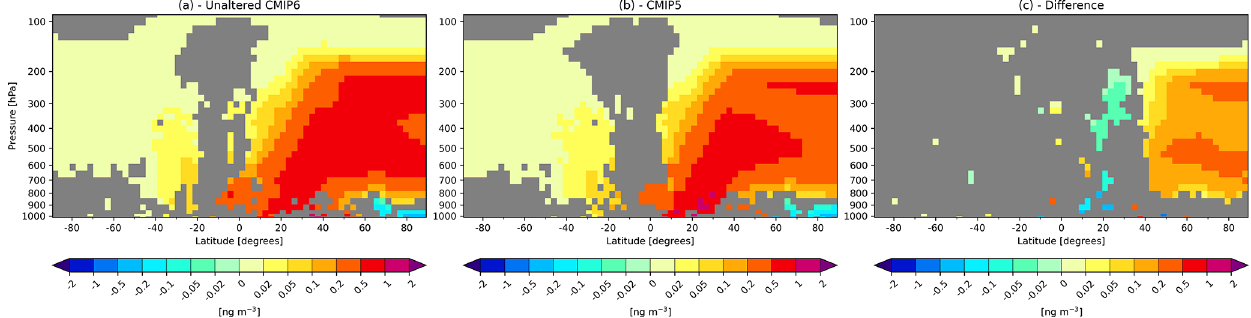
Figure 3. Zonally averaged aviation-induced changes in black carbon concentration simulated by the model using the unaltered CMIP6 (a) and CMIP5 (b) inventory and their difference (c) . Gray areas mark non-significant changes at the 95% confidence